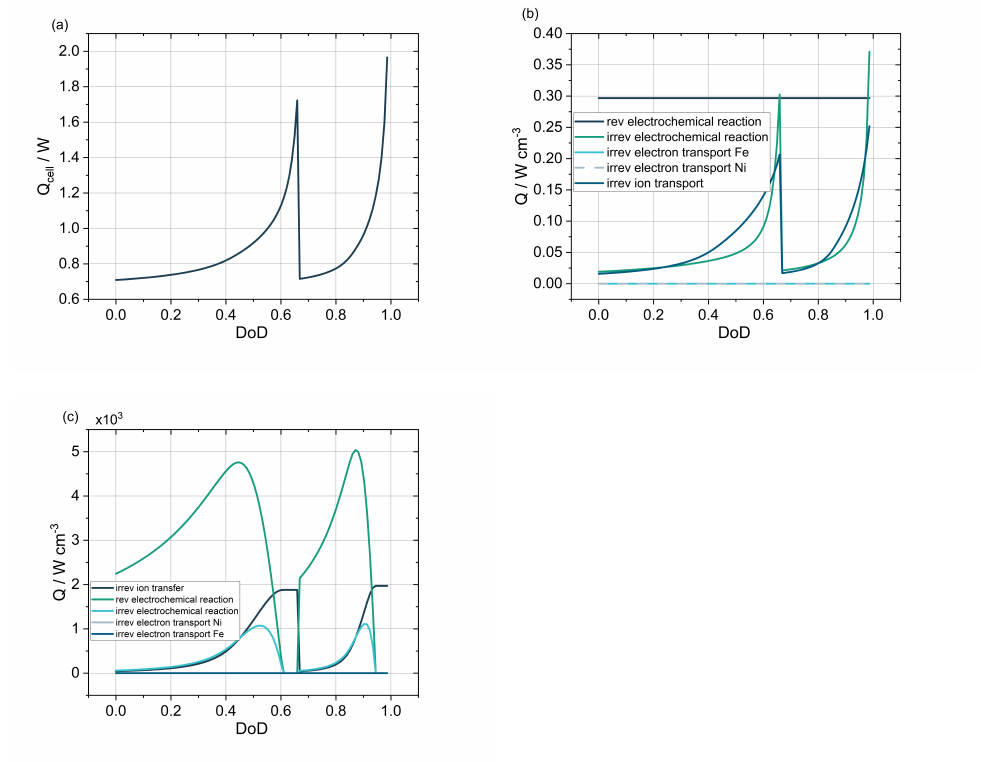
Figure 8. Results of the thermal model. ( a ) Overall heat generation of the reaction volume in one discharging cycle. ( b ) Contribution of the different heat generation terms. ( c ) Heat generation in a single segment (#50) over one discharging cycle with